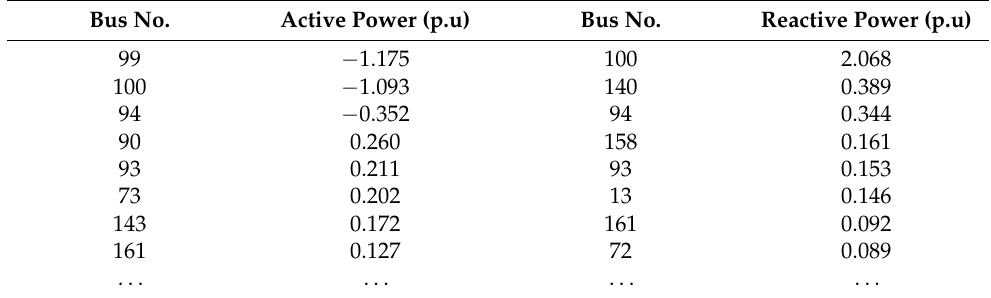
Table 2. Intermediate power flow iteration error.